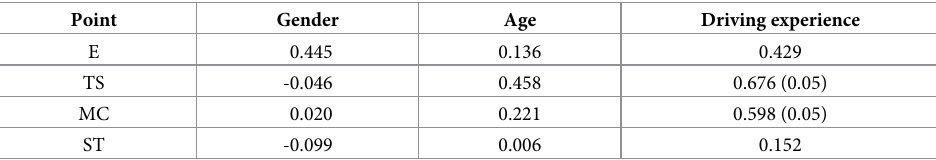
Table 5. Correlation between D value and the personal attributes